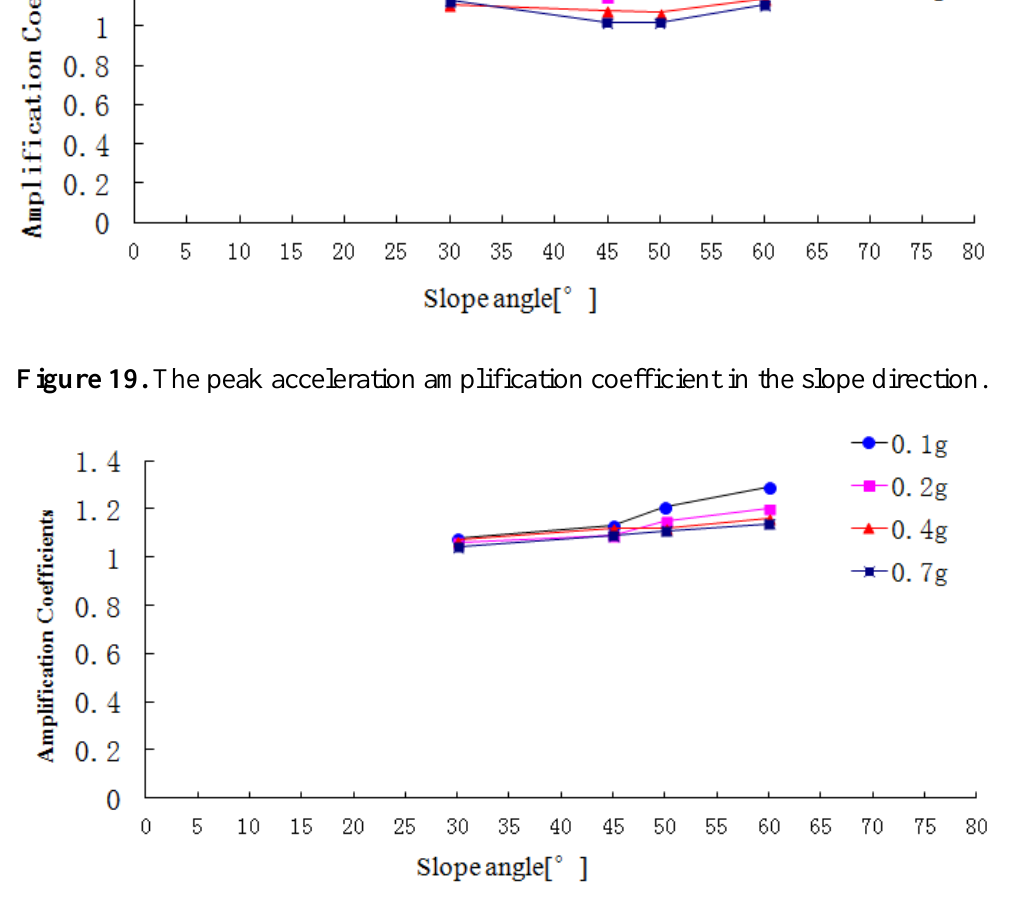
Figure 20. The peak acceleration amplification coefficient in the vertical